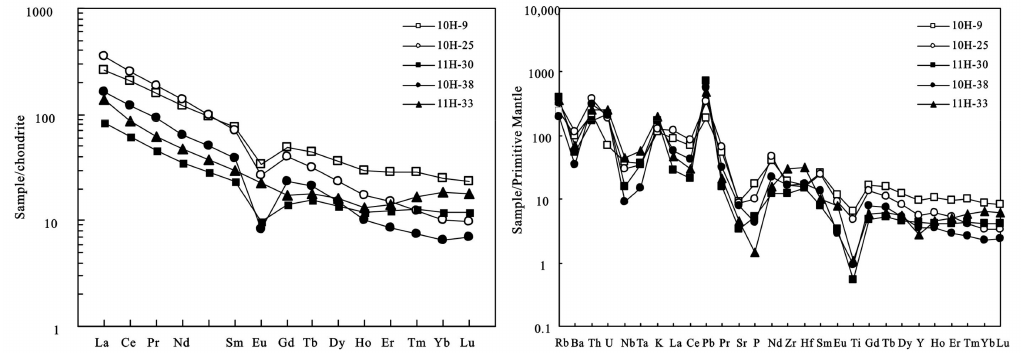
Figure 7. Chondrite-normalised rare-earth element (REE) patterns and primitive mantle-normalised trace element patterns for the studied biotite granite samples (the normalization factors after Sun and McDonough